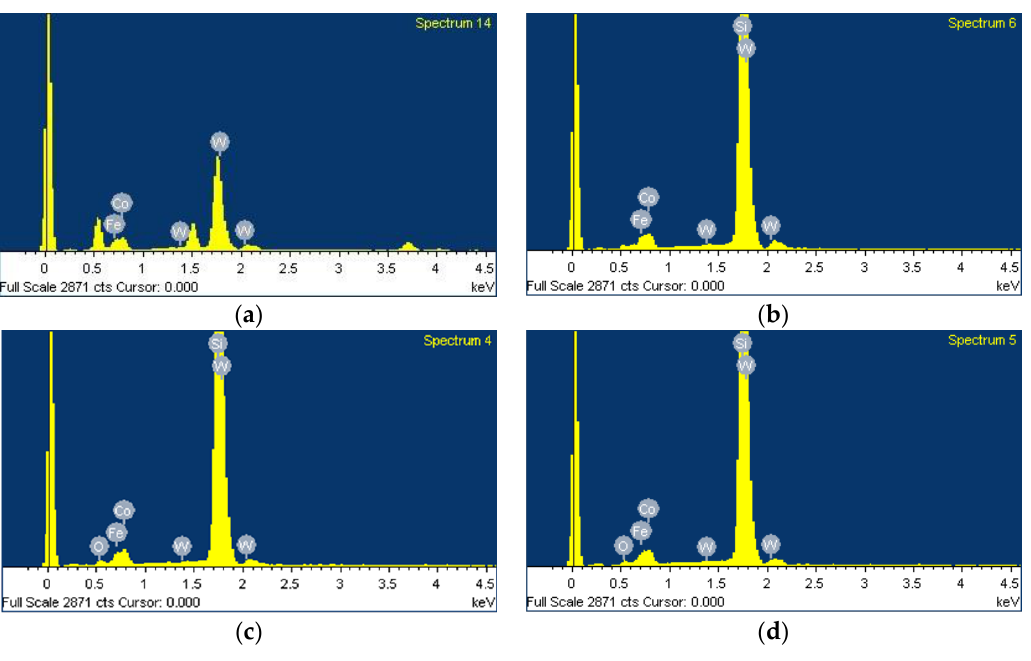
Figure 4. EDS patterns of CoFeW 50 nm. ( a ) RT, ( b ) annealed at 300 °C; ( c ) annealed at 350 °C; ( d ) annealed at 400 °C.